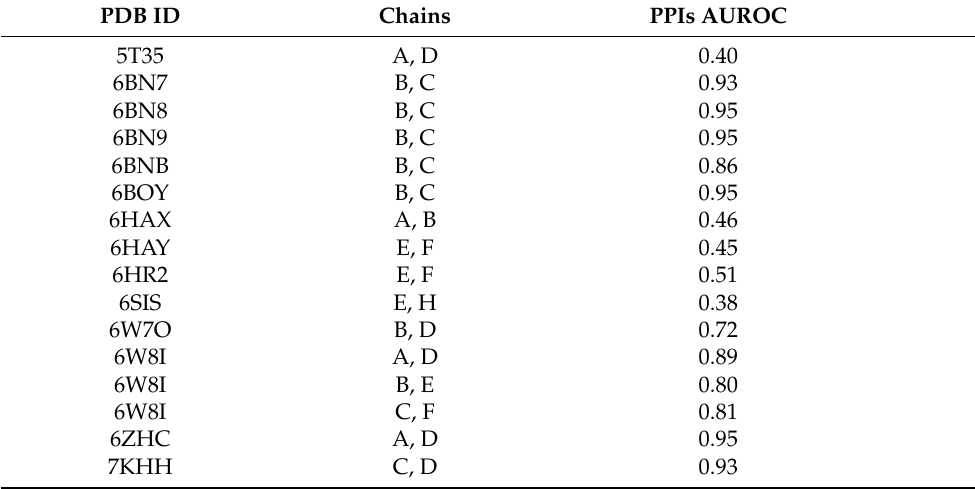
Table A5. AUROC scores for PPI prediction of our model trained on the MaSIF dataset (see Figure 4, panel